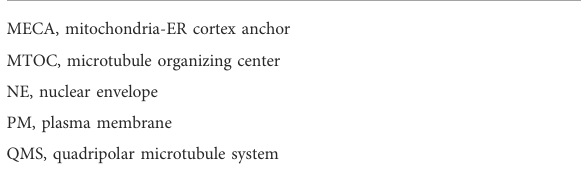
TABLE 1 A list of abbreviations and their de fi nitions used in the